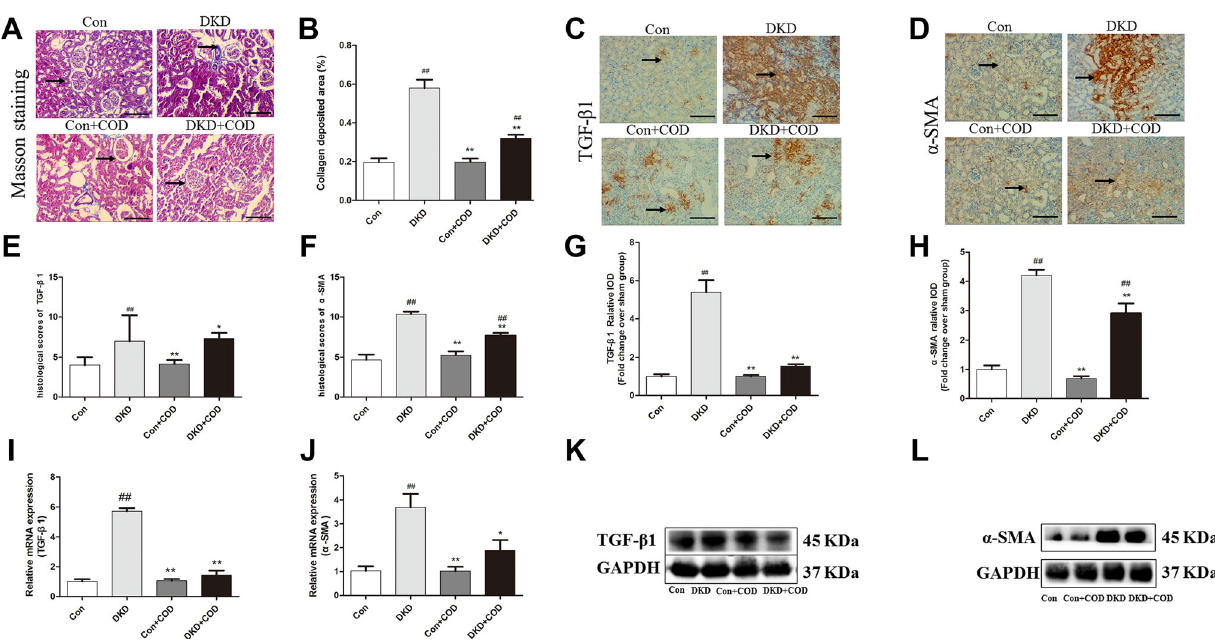
Fig. 7 Effect of COD on inhibition of renal fibrosis and fibrosis markers in DKD rats. a The photomicrographs of Masson’s trichrome-stained kidney sections from the four experimental groups on day 30 after COD treatment. Scale bar: 600 l m ( 9 200). b The collagen deposition area was assessed by Masson’s trichrome staining and was quantified using Image-Pro Plus 6.0 analysis software. The image and values are represented as mean ± SD. The expressions of TGF- b 1 ( c ) and a -SMA ( d ) were determined by IHC staining in the kidney sections of rats from the four groups on day 30 after COD treatment. The histological score of TGF- b 1 ( e ) and a -SMA ( f ) was